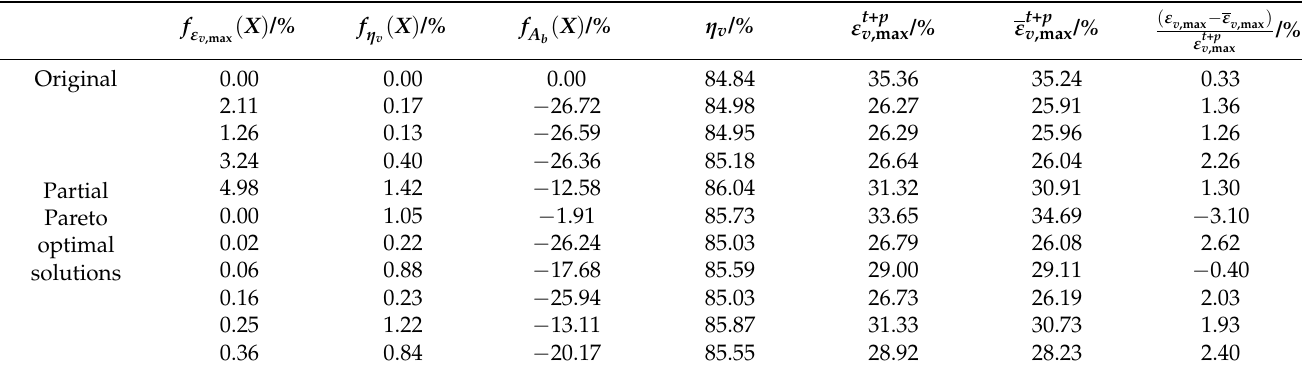
Table 5. Partial Pareto optimal solutions and validation results of multiobjective optimization for SRM